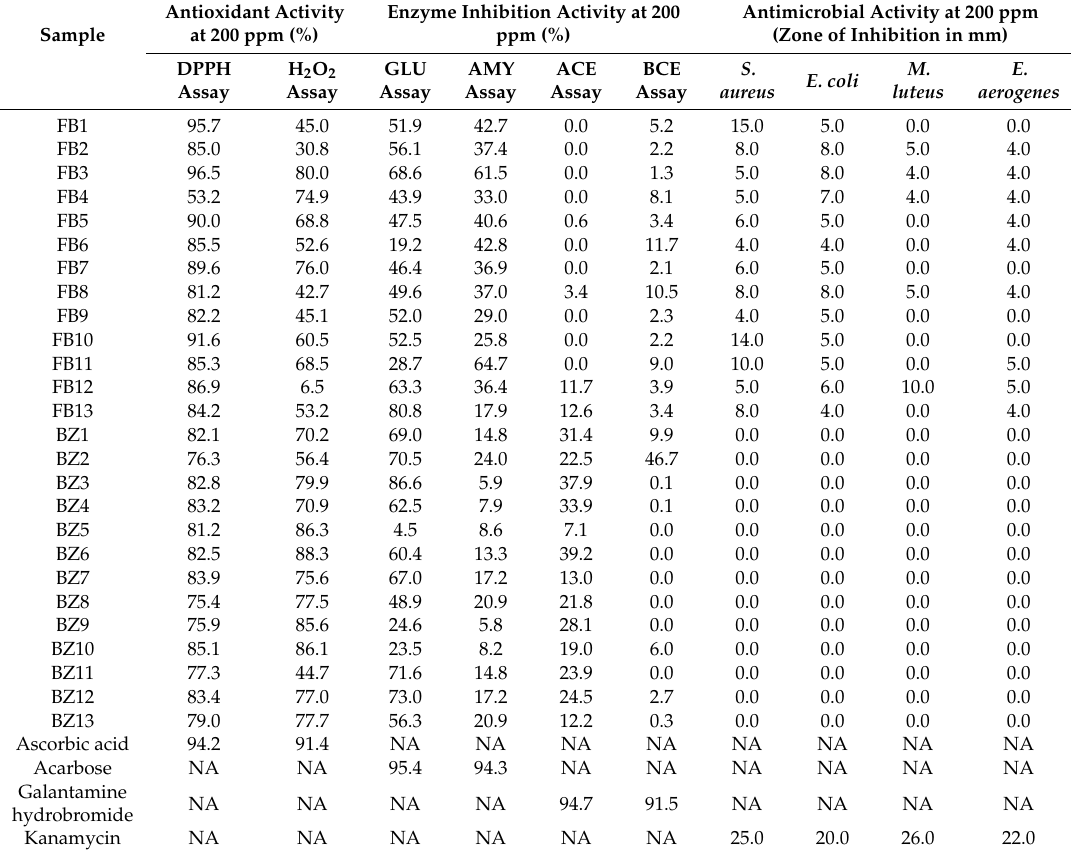
Table 3. Biological activities of ferrocenyl amides (FB1-FB13) and organic analogues (BZ1-BZ13).